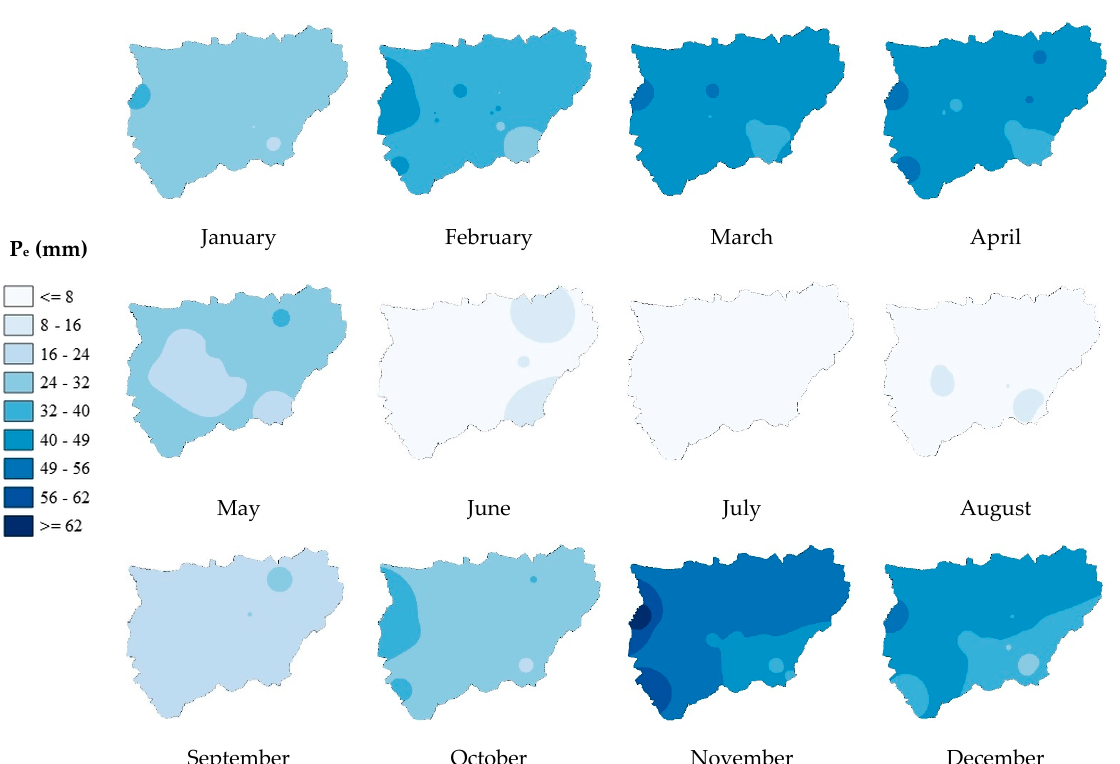
Figure 5. Monthly variation in ET o . (Source of data: agrometeorological stations of the agroclimatic information network of Andalusia. The scale of color is presented on the left of the figure).